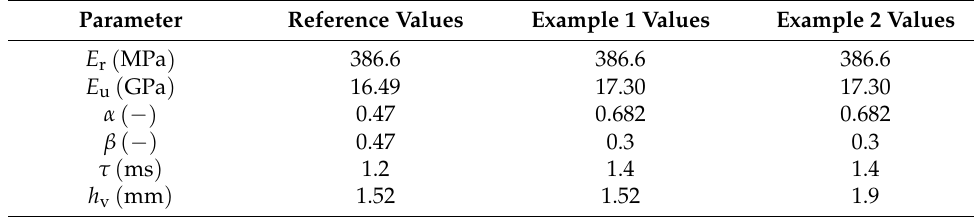
Table 3. Comparison between reference values and the ones of Examples 1 and